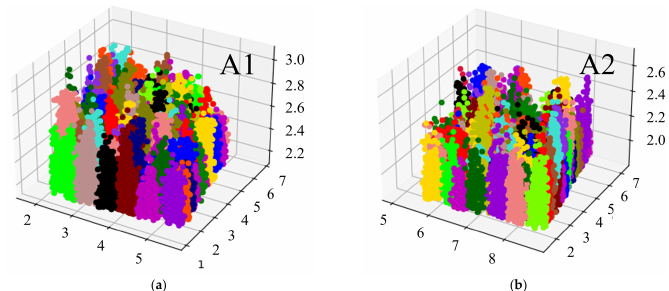
Figure 12. Segmentation of individual maize plants: ( a ) A1, ( b ) A2.